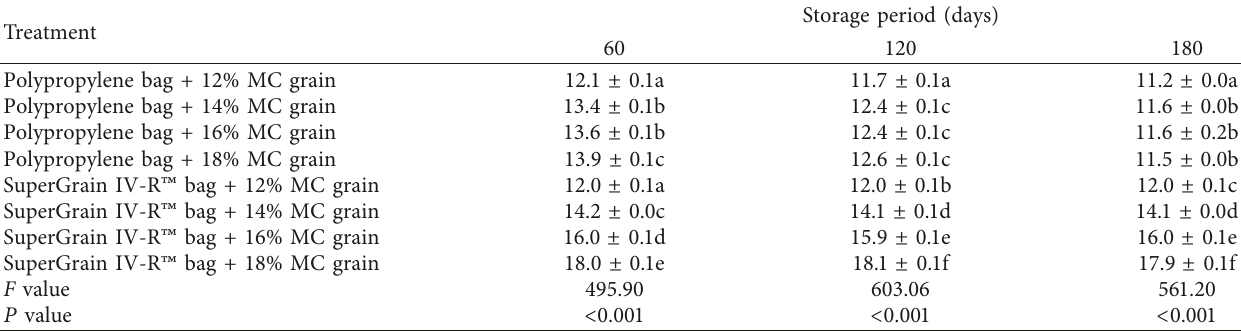
Table 1: Mean ( ± SE) percent grain moisture content after 60, 120, and 180 days of storage. Treatment